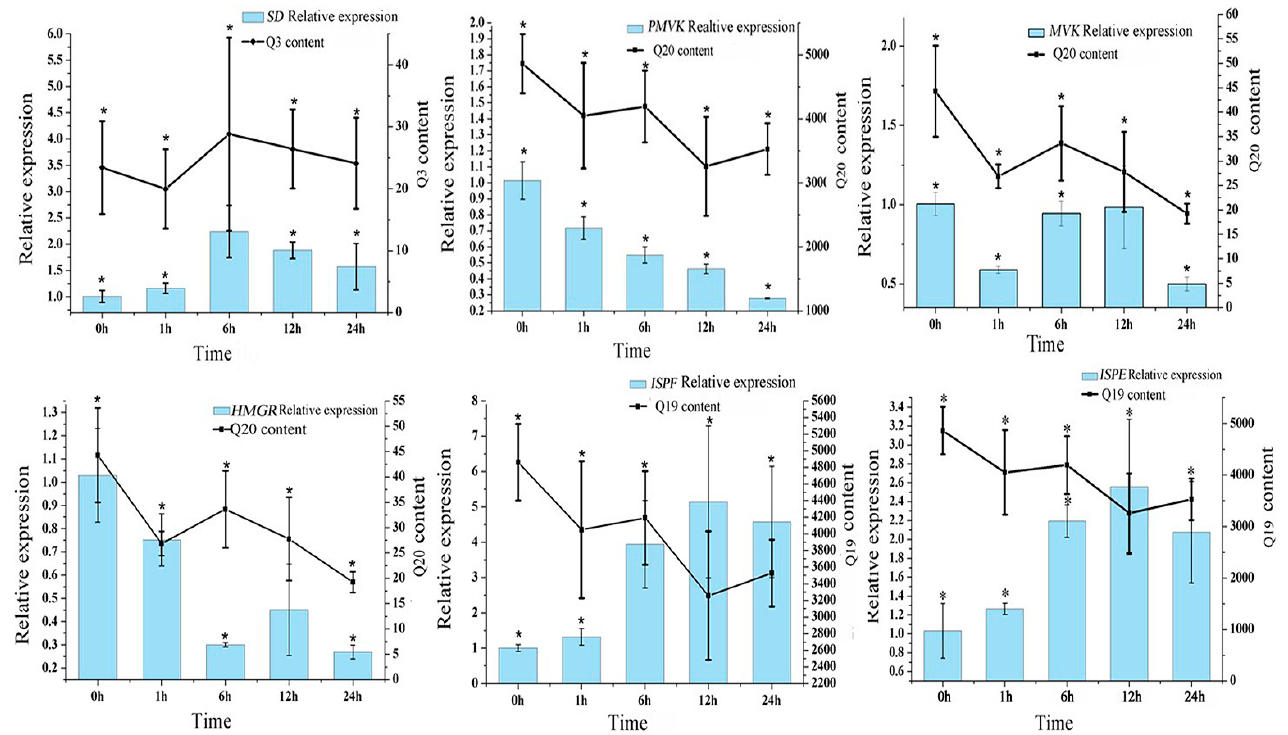
Figure 6. The expression levels of six genes were significantly related to the contents of three an- thraquinones after 0, 1, 6, 12, and 24 h under MeJA treatment. “*” indicates significant differences ( p < 0.05) between the samples. ( p < 0.05) between the